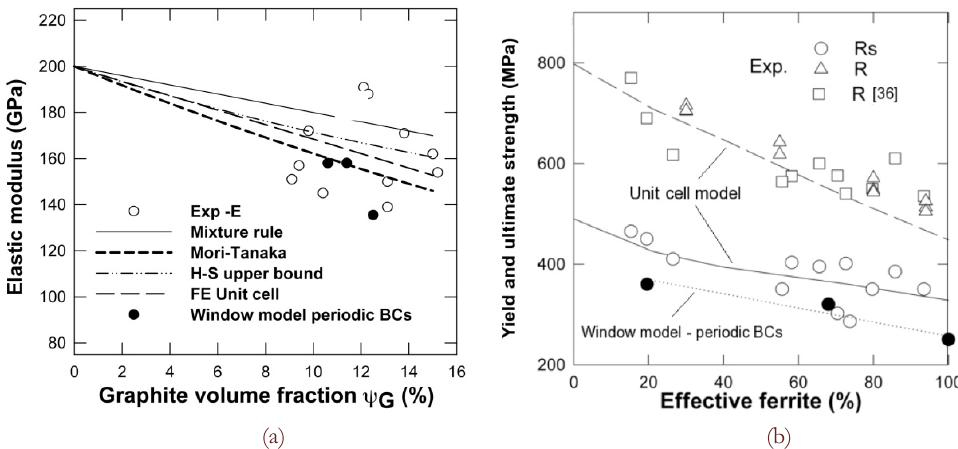
Figura 7: (a) effetto del contenuto in grafite sulle proprietà elastiche della ghisa nodulare; (b) effetto del contenuto in ferrite sulla resistenza della ghisa nodulare